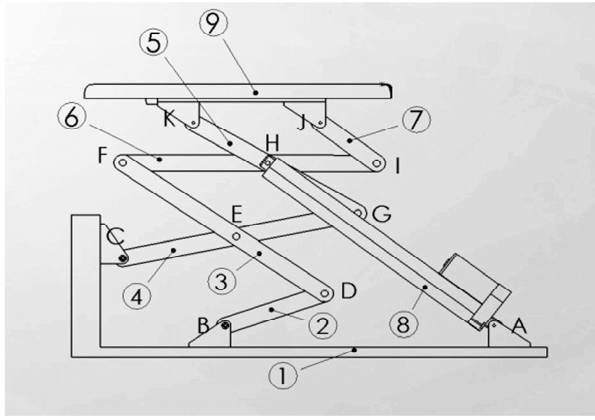
Figure 1. Configuration of the retained geometry for the intelligent seating assist toilet: the bars are identified with numbers and the joints by letters.